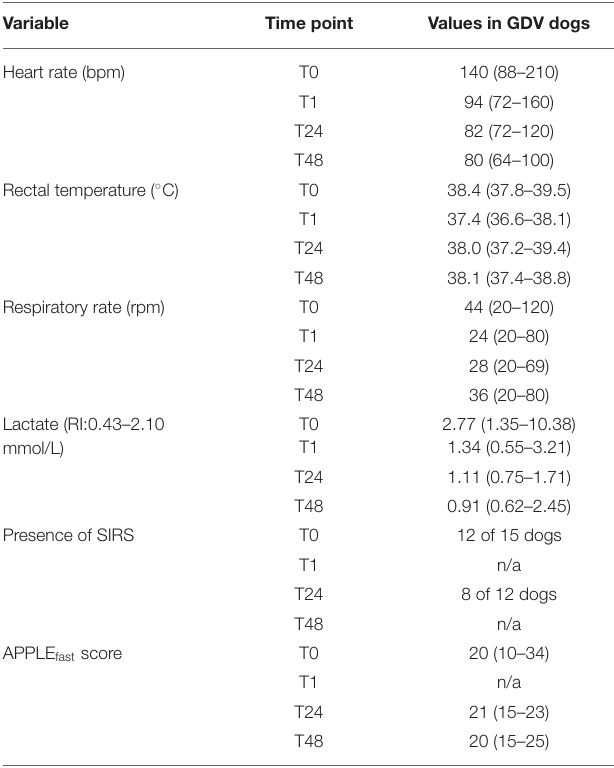
TABLE 1 | Clinical parameters, SIRS, and APPLE fast scores at admission (T0), post-surgery (T1), 24h (T24), and 48h (T48) post-surgery in dogs with GDV.